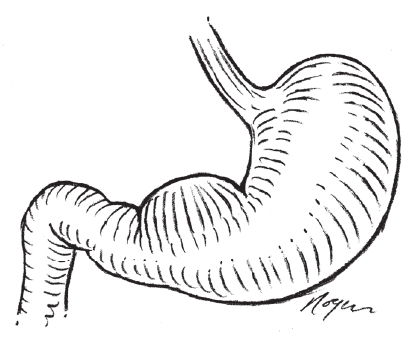
Figure 2: Cystic duplication sketch. Sketch by Paul Rogers, CMI, medical illustrator/photographer/videographer/graphics, Cooper University